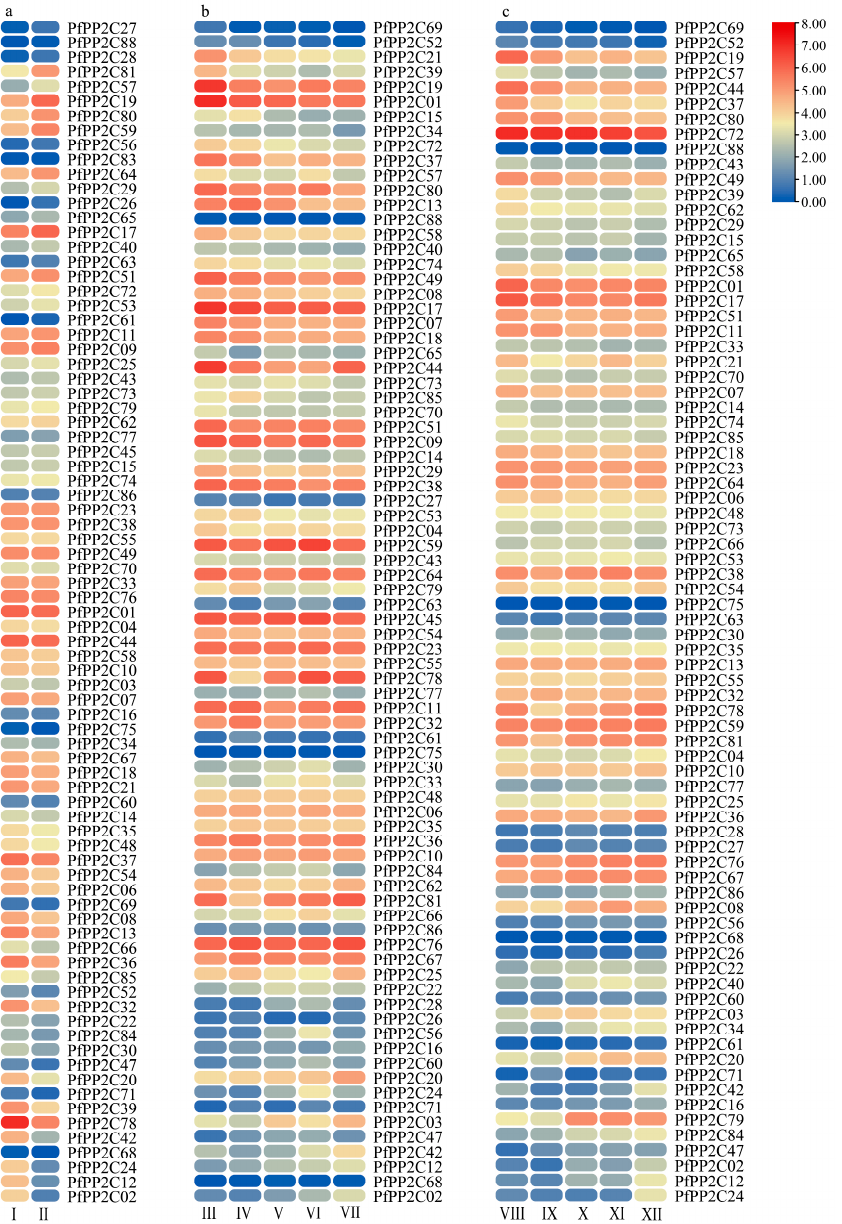
Figure 7. Expression analysis of the PP2C gene of P. fortunei during the development of witches’ broom: ( a ) I is the P. fortunei seedling, II is the PaWB seedling; ( b ) III is the PaWB seedling, IV, V,